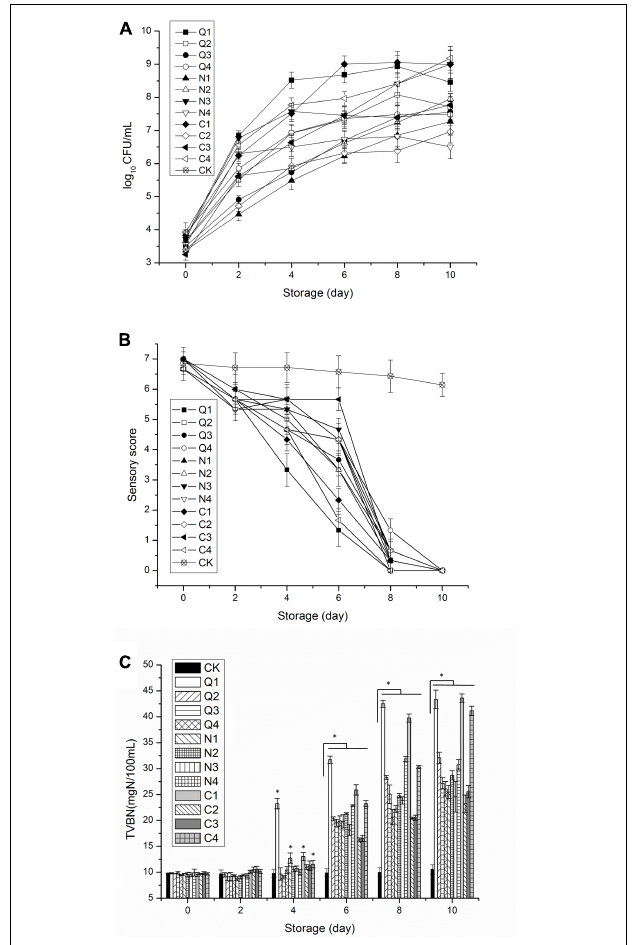
FIGURE 1 | Comparison of spoilage capabilities of sterile fish juice inoculated with different bacteria (Q1–Q4, N1–N4, and C1–C4) during the storage at 4 ◦ C. (A) Total viable count, (B) sensory score, and (C) total volatile base nitrogen (TVB-N). The error bars indicate standard deviation ( ± SD). Statistical significance was marked by the asterisk (* represents P <